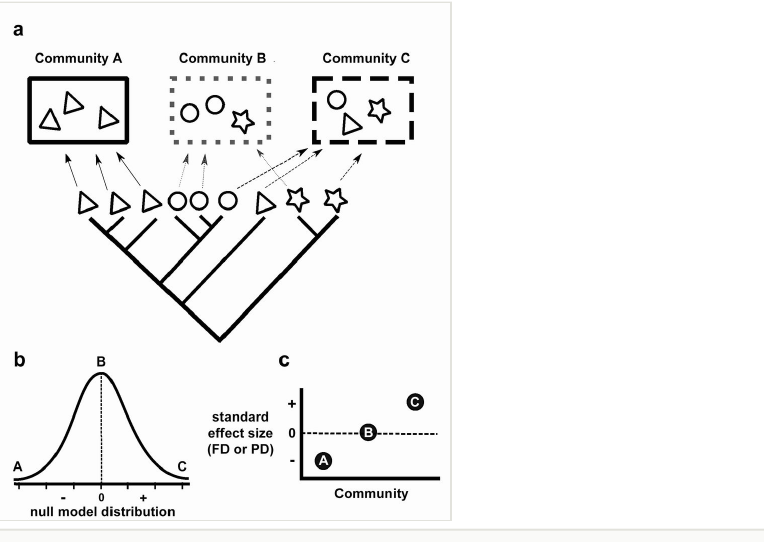
Figure 1. Predicted e ff ects of interspeci fi c competition and environmental fi ltering on FD and